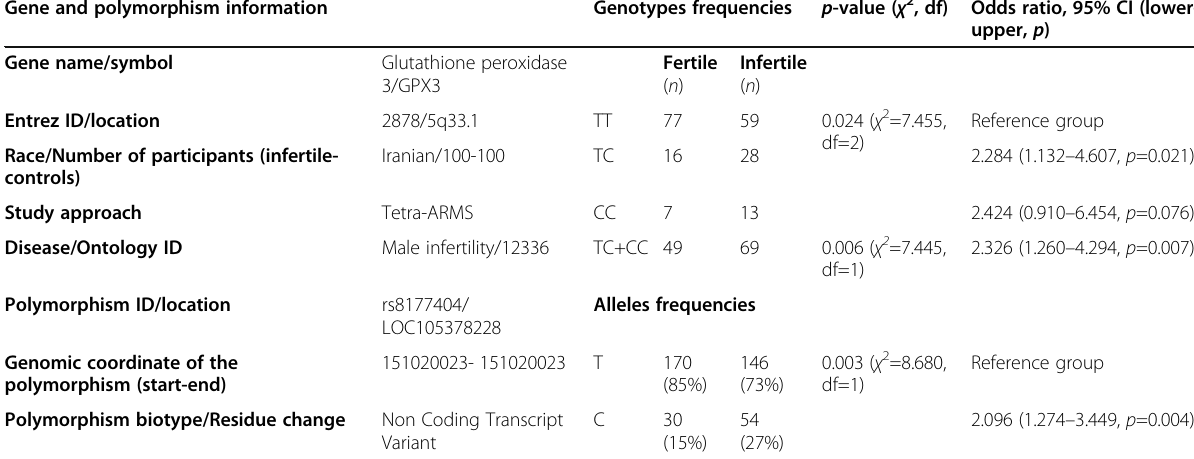
Table 4 The frequency of GPX3 rs8177404 (T to C) genotypes, alleles, and odds ratios in fertile ( n = 100) and infertile ( n = 100) males using χ 2 test and regression logistics